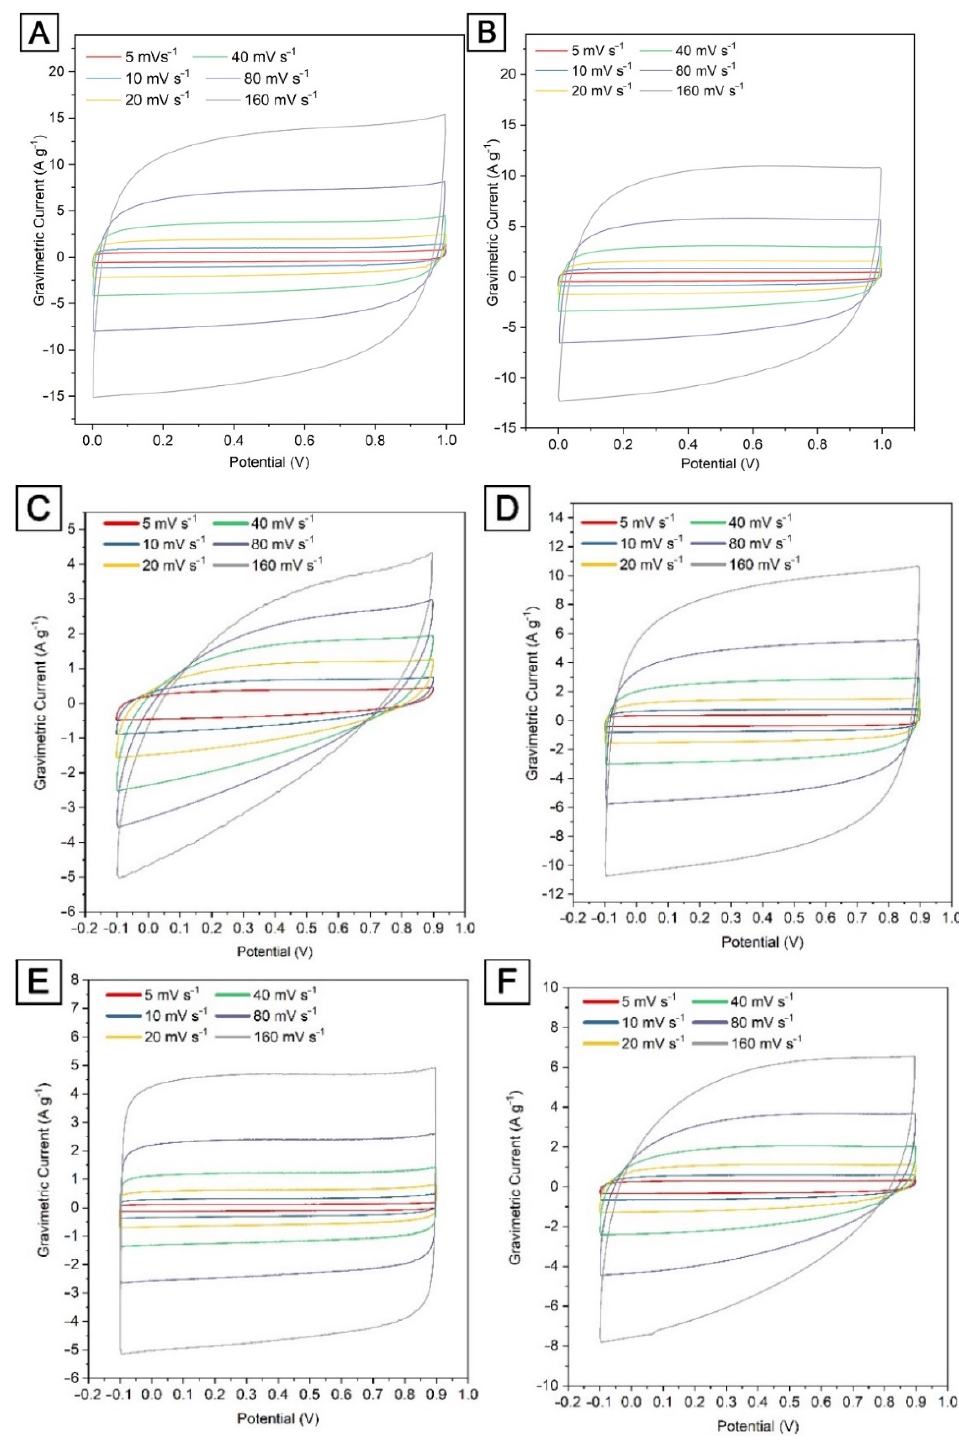
Figure 4. Cyclic voltammetry curves for electrodes based on ( A ) AKS-700, ( B ) APS-700, ( C ) AKS-800, ( D ) APS-800, ( E ) AKS-900 and ( F ) APS-900 at different scanning rates: 5, 10, 20, 40, 80, 160 mV s − 1 .